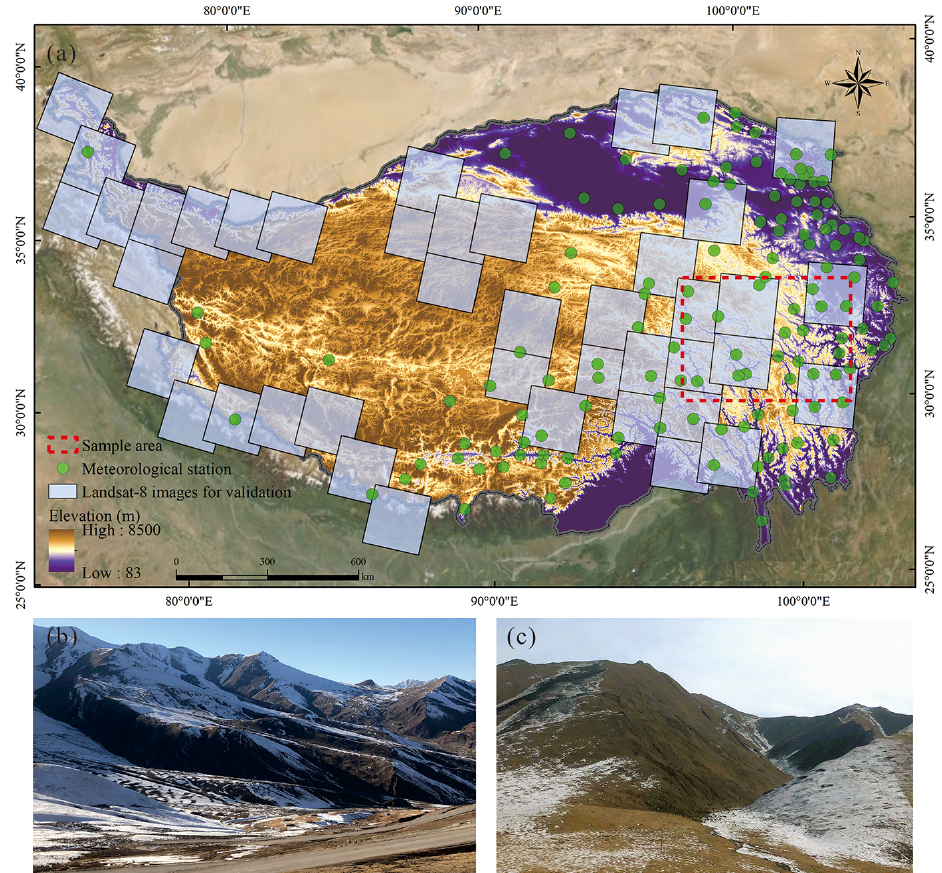
Figure 1. Topography, meteorological stations, and survey photos of the TP. (a) Surface elevation and distribution of meteorological stations in the TP. Landsat images utilized for validation and sample area are also shown; (b) and (c) in situ photos from field survey in the TP.